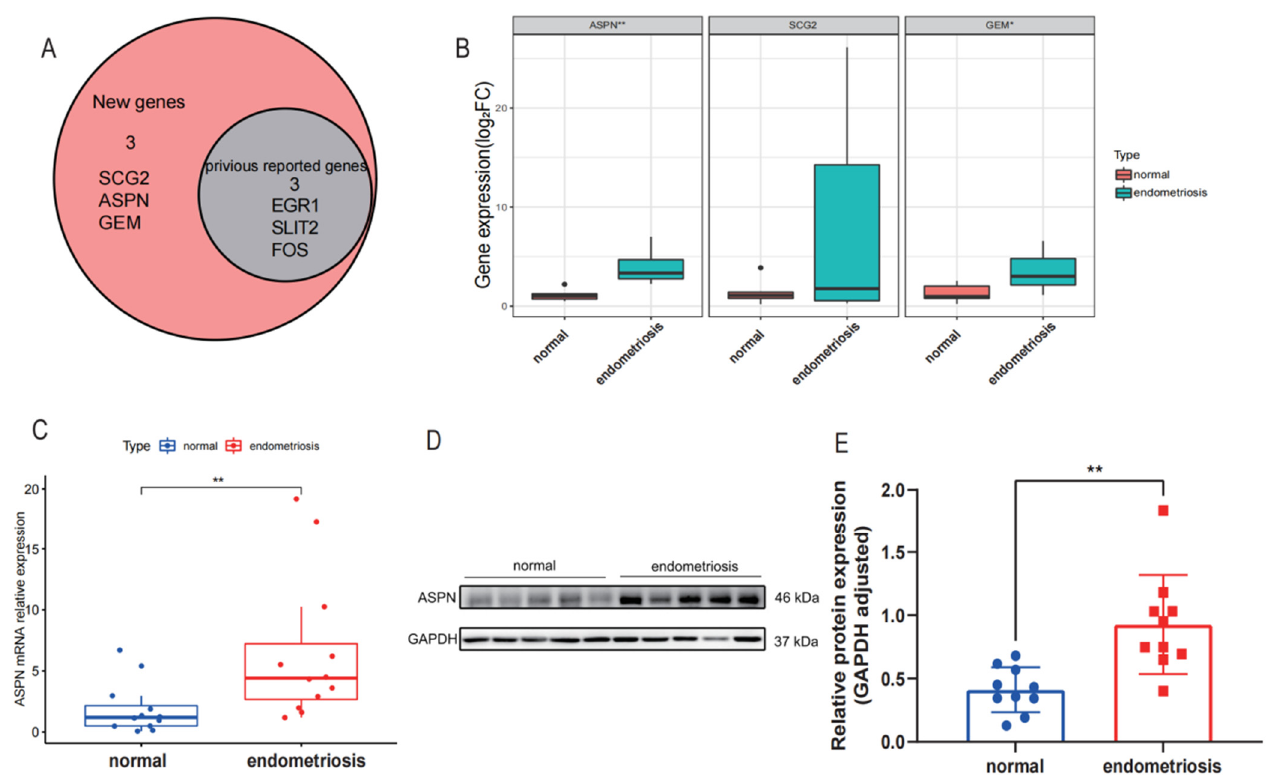
Figure 5. Validation of the expression of important biomarkers and screening for new biomarkers. ( A ) New biomarker for endometriosis. ( B ) The degree of ASPN, SCG2, and GEM mRNA expression in endometriosis and control samples. ( C ) Normal samples and Endometriosis ASPN mRNA expression levels. p = 0.0045 for mean ± SD. ( D , E ) Endometriosis and control sample ASPN protein expression levels. p = 0.0013 for mean ± SD (* p < 0.05, ** p < 0.01).